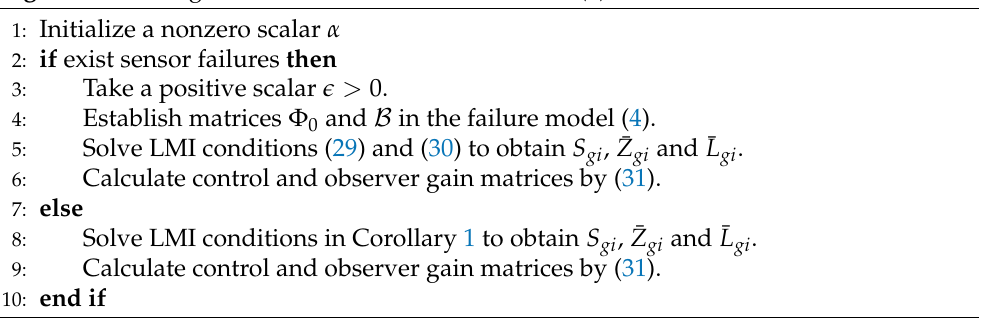
Algorithm 1 Design of the observer-based controller